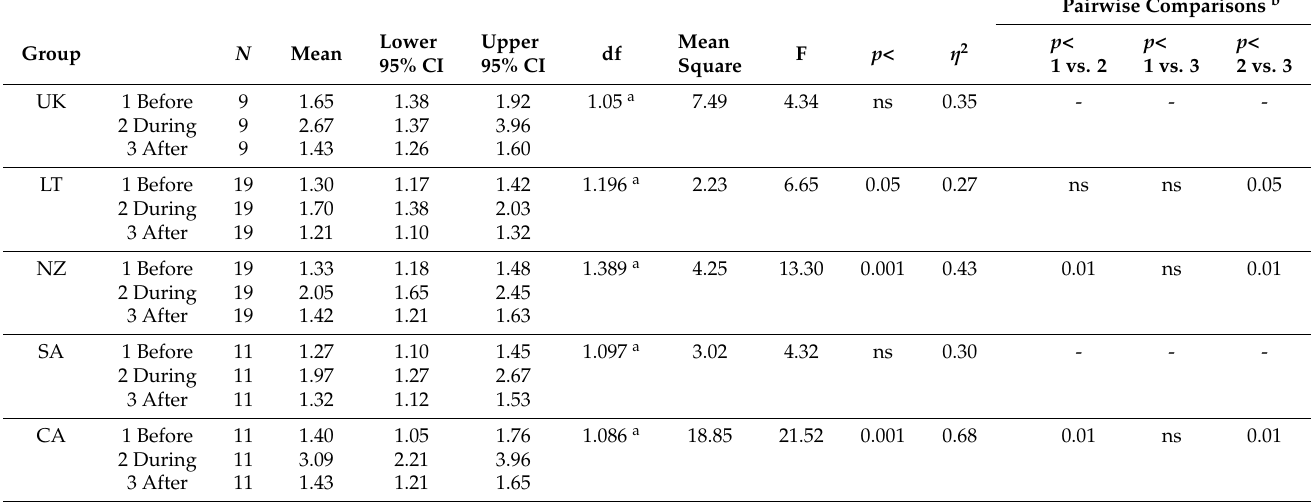
Table 9. The results of a repeated measures (within-subjects) ANOVA test assessing differences in the coherence score for all five groups during 15-min periods before (1), during (2) and after (3) using the Heart lock-In technique ( a —Mauchly’s Test of Sphericity was violated, Greenhouse-Geisser df correction applied; b —Adjustment for multiple comparisons: Bonferroni). Note that a coherence score below one is considered as low coherence, scores between one and two as medium, and scores above two as high levels of coherence. It can be seen, for example, that California’s and New Zealand’s group members’ HRV coherence was significantly higher during the HLI period than before and after the HLI period,